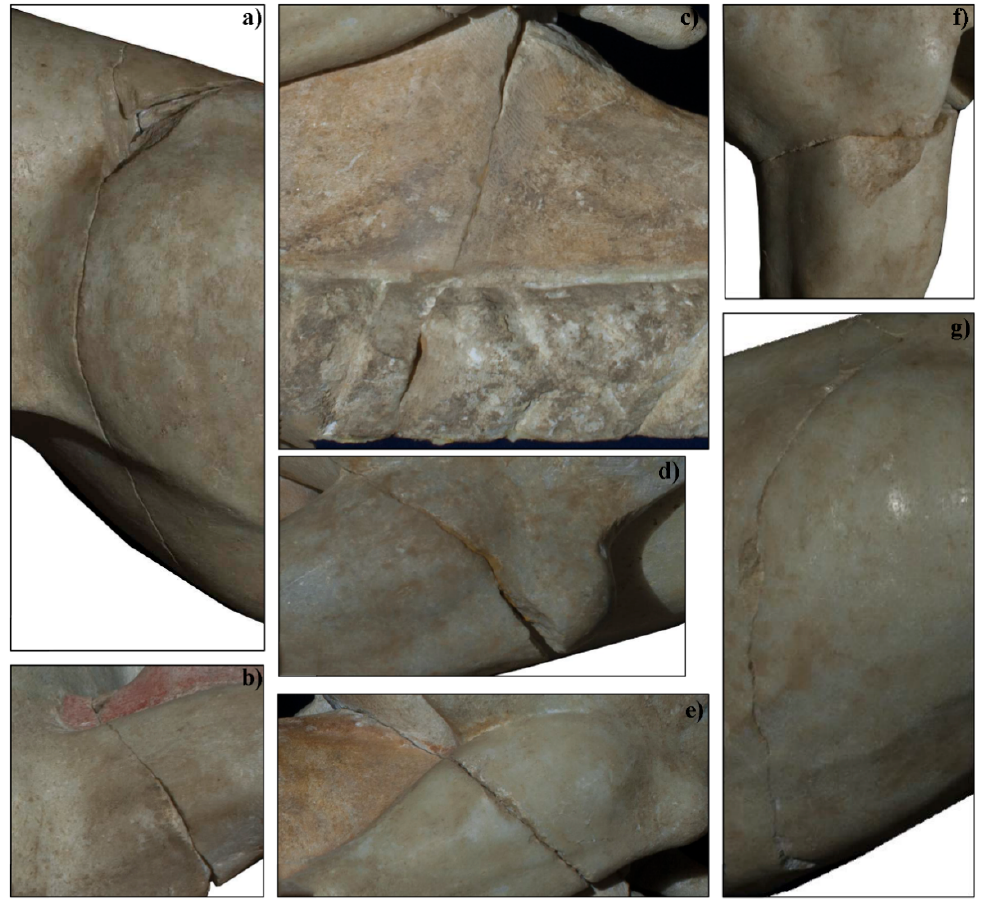
Figure 7. Details of the most significant microlesions ( a – g ).